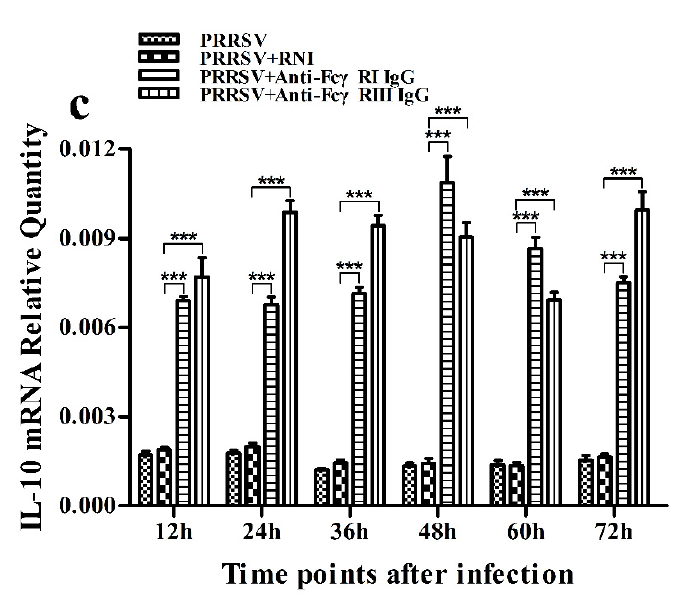
Figure 13. Effect of Fc γ RI or Fc γ RIII on PRRSV-induced mRNA expression of cytokines in porcine AMs. Relative quantitative RT-PCR analysis of cytokine mRNA levels in PRRSV-infected cells pretreated with RNI, anti-Fc γ RI IgG or anti-Fc γ RIII IgG. ( a ) IFN- α mRNA level, ( b ) TNF- α mRNA level, ( c ) IL-10 mRNA level. *** p < 0.001, ** p < 0.01, * p < 0.05.